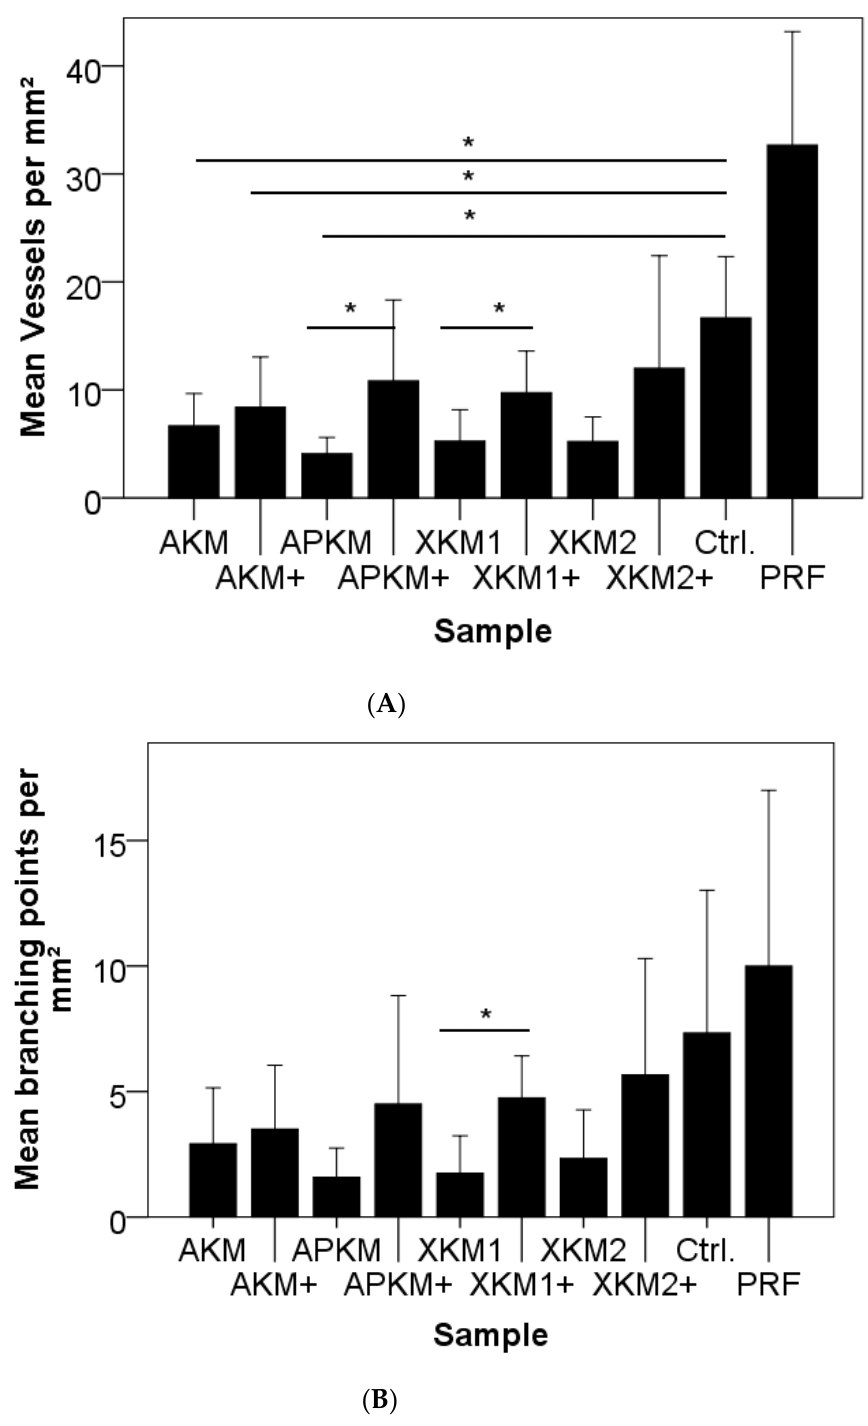
Figure 6. Newly formed vessels per mm 2 ( A ) and branching points per mm 2 ( B ) of the CAM after 24 h of incubation of BSMs with (+)/without PRF in comparison to the negative control and PRF alone (* p < 0.05).